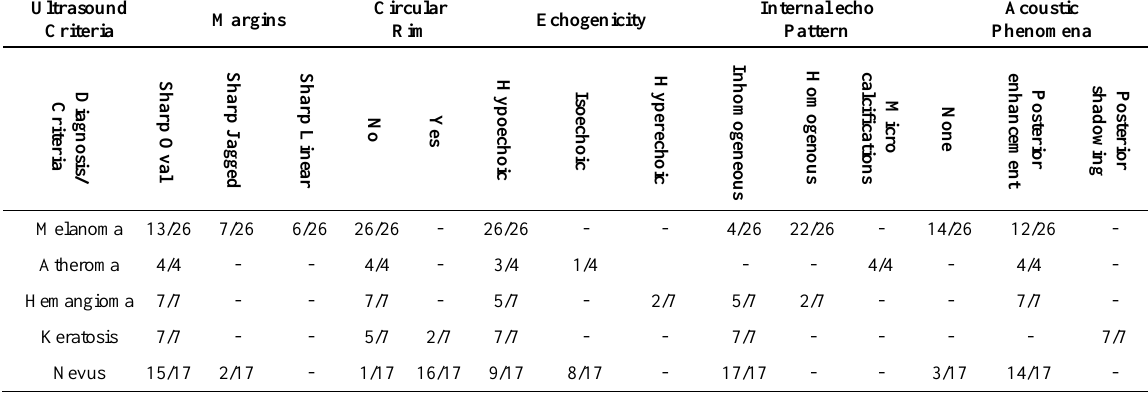
Internal echo Pattern